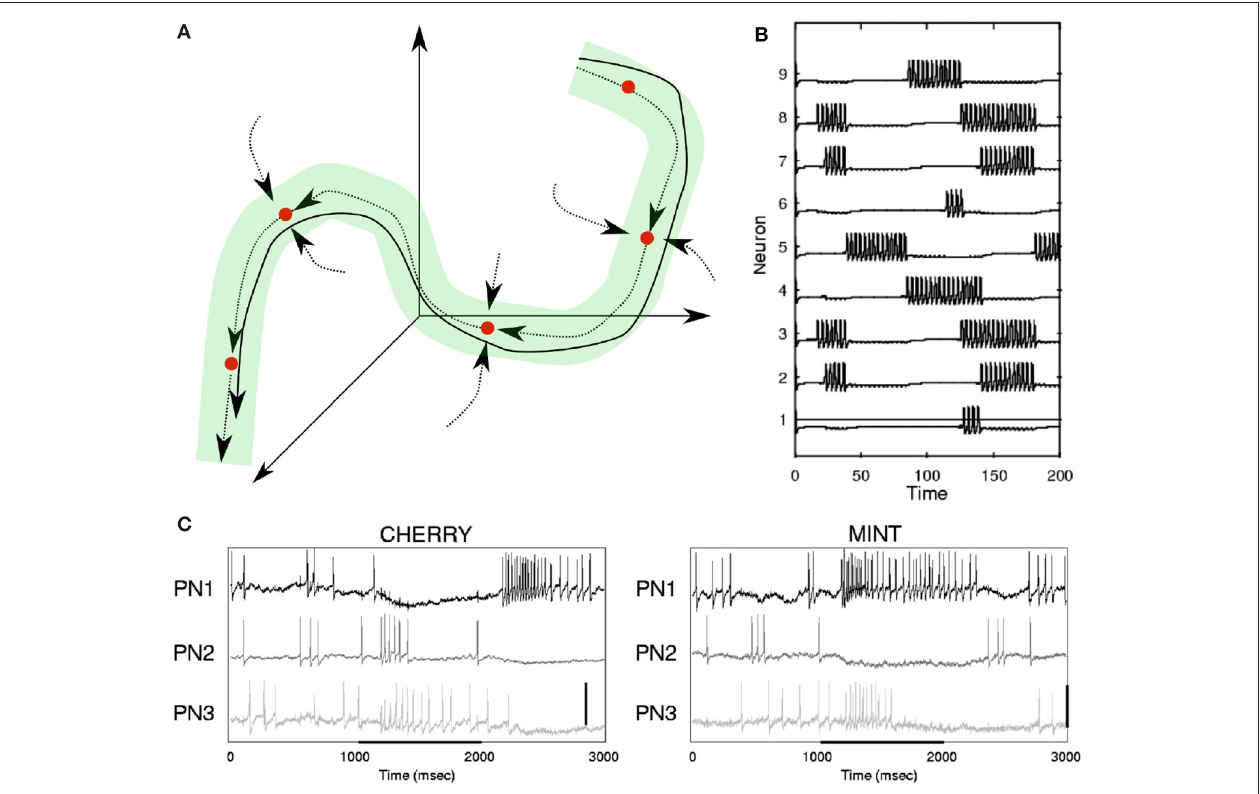
FIGURE 3 | (A) Illustration of continuodiscrete dynamics based on Stable Heteroclinic Channels (SHC, see section 2.2.2 and Table 1 ). The solid line represents a continuous heteroclinic trajectory in three-dimensional phase space and the dotted lines indicate invariant manifolds between saddle states (see Table 1 ). The green tube illustrates a Stable Heteroclinic Channel. All heteroclinic trajectories originating in the SHC will remain inside of it. This is a type of WLC dynamics. (B) Simulation of an SHC-trajectory based on Lotka-Volterra dynamics, where a point in phase space determines the firing rate of each neuron. (C) Neuronal responses to odor representation in the locust brain. (B,C) Are adapted from Rabinovich et al. (2001). Copyright (2001) by the American Physical